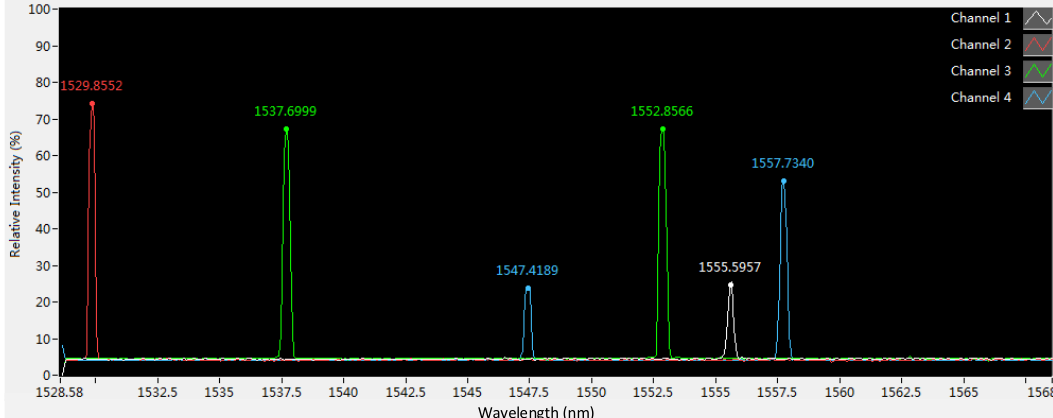
Figure 17. The spectrum of six FBG integrated in the